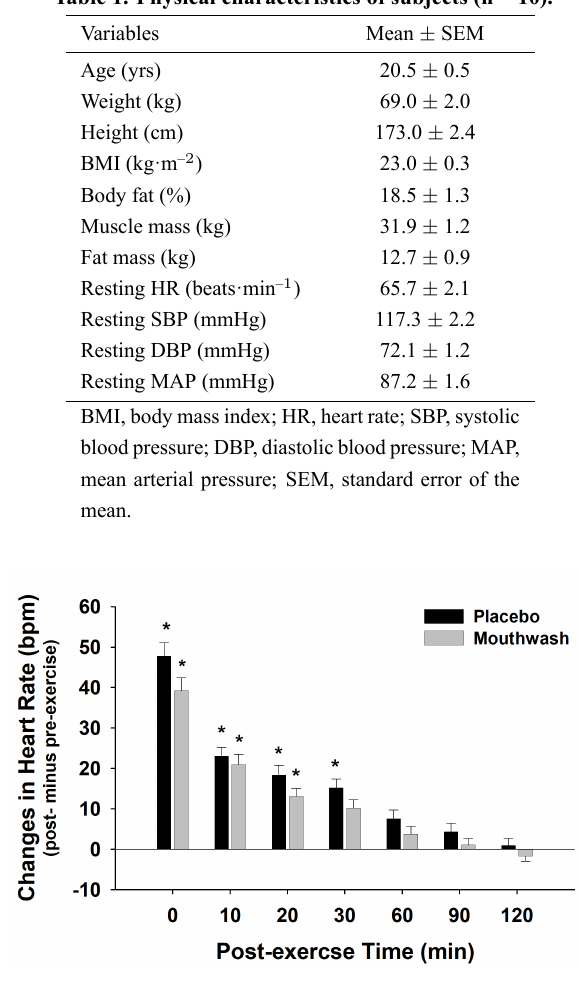
Table 1. Physical characteristics of subjects (n = 10).